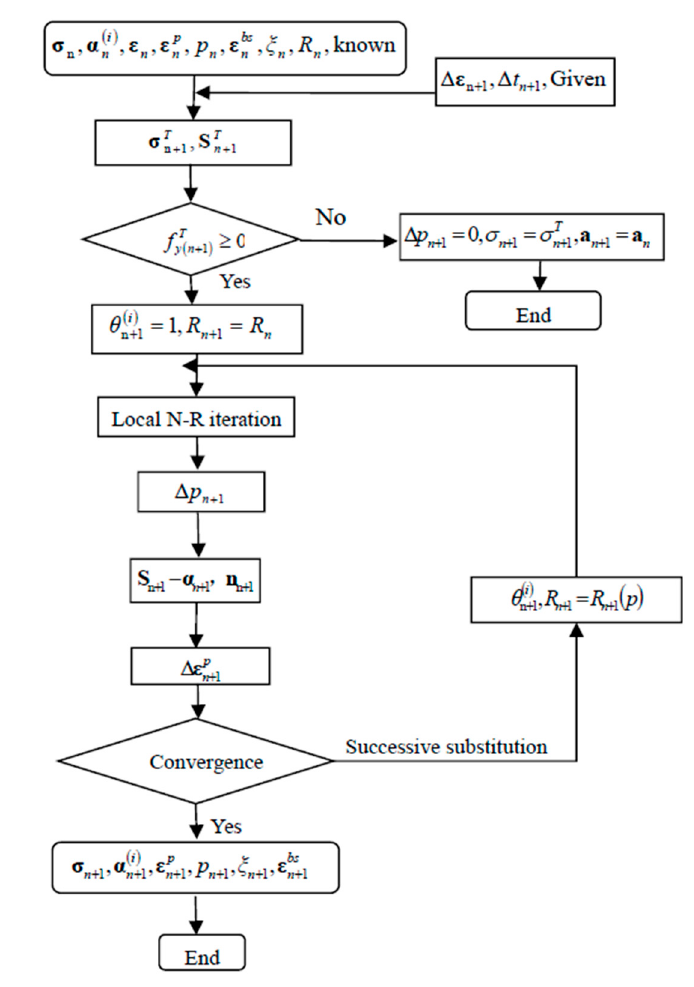
Figure 14. Flow diagram of the proposed model.